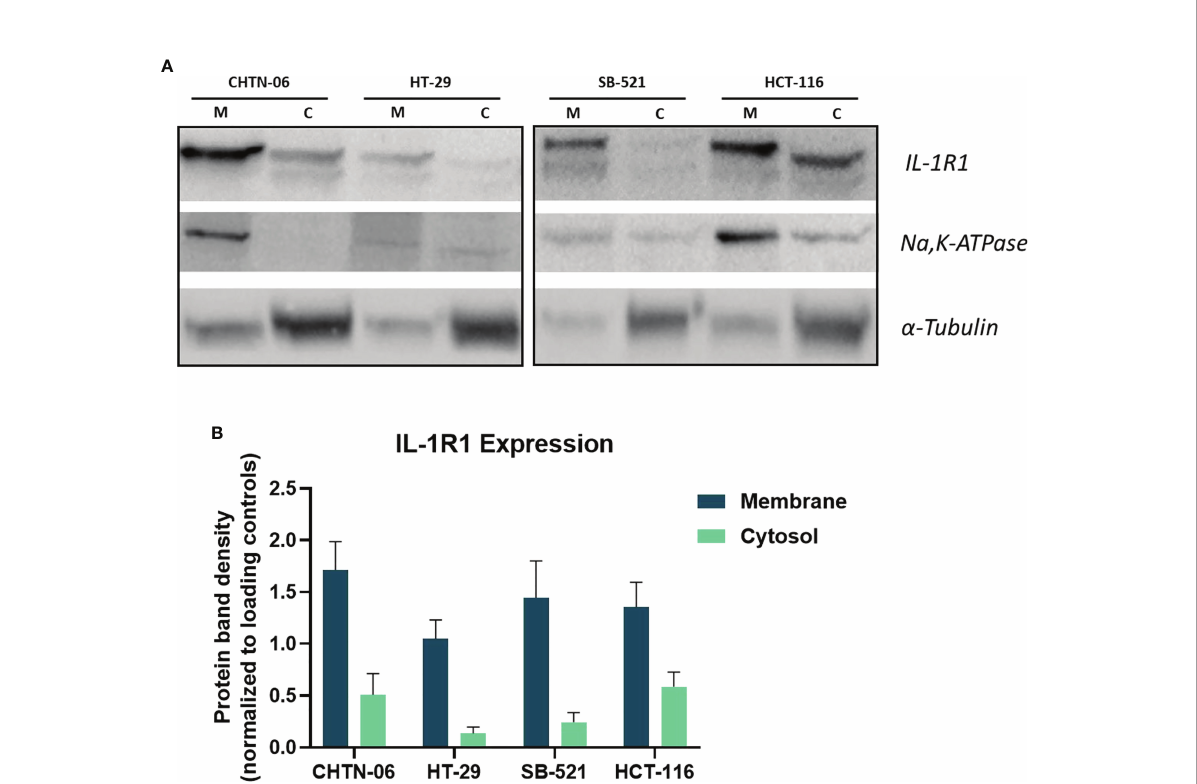
FIGURE 2 Expression levels IL-1R1 in membrane and cytosol fractions in AA and CA colon cancer cell lines. (A) Representative images of Western Blot for detection of IL-1R1. Na,K-ATPase and a -tubulin were used as loading controls. M= Membrane, C= Cytosol. (B) Densitometry analysis of IL-1R1 levels in membrane and cytosol fractions. Membrane protein was normalized to ATPase and cytosolic protein was normalized to a -tubulin. Data are representative of three independent experiments. Error bars represent